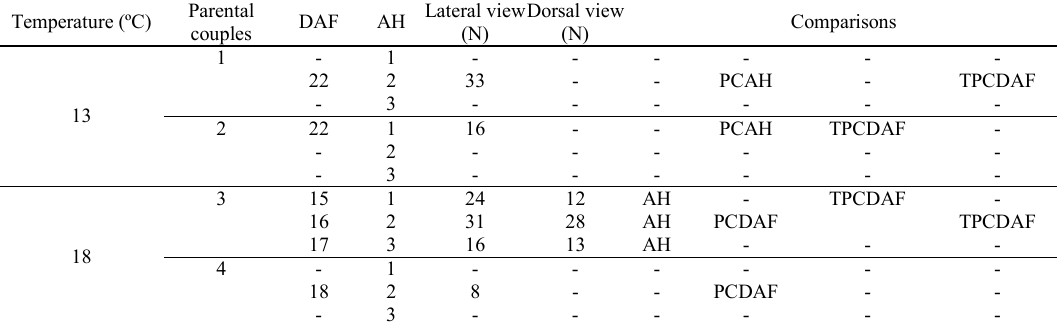
Table 1. Data (lateral and dorsal views) obtained for newly hatched Odontesthes hatcheri embryos of Lake Carrilafquen. Temperature (T = 13 and 18ºC), parental couples (PC 1 to 4), days after fertilization (DAF), and age of newly hatched embryos (AH 1 to 3) are indicated. Comparisons include the effect of AH, DAF, PC, the combined effect of temperature and PC (TPC) at AH 1 and AH 2, and the combined effect of PC and DAF (PCDAF) at AH 2. N = number of individuals.